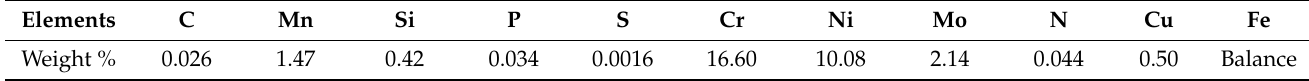
Table 1. Chemical composition of 316L stainless steel.